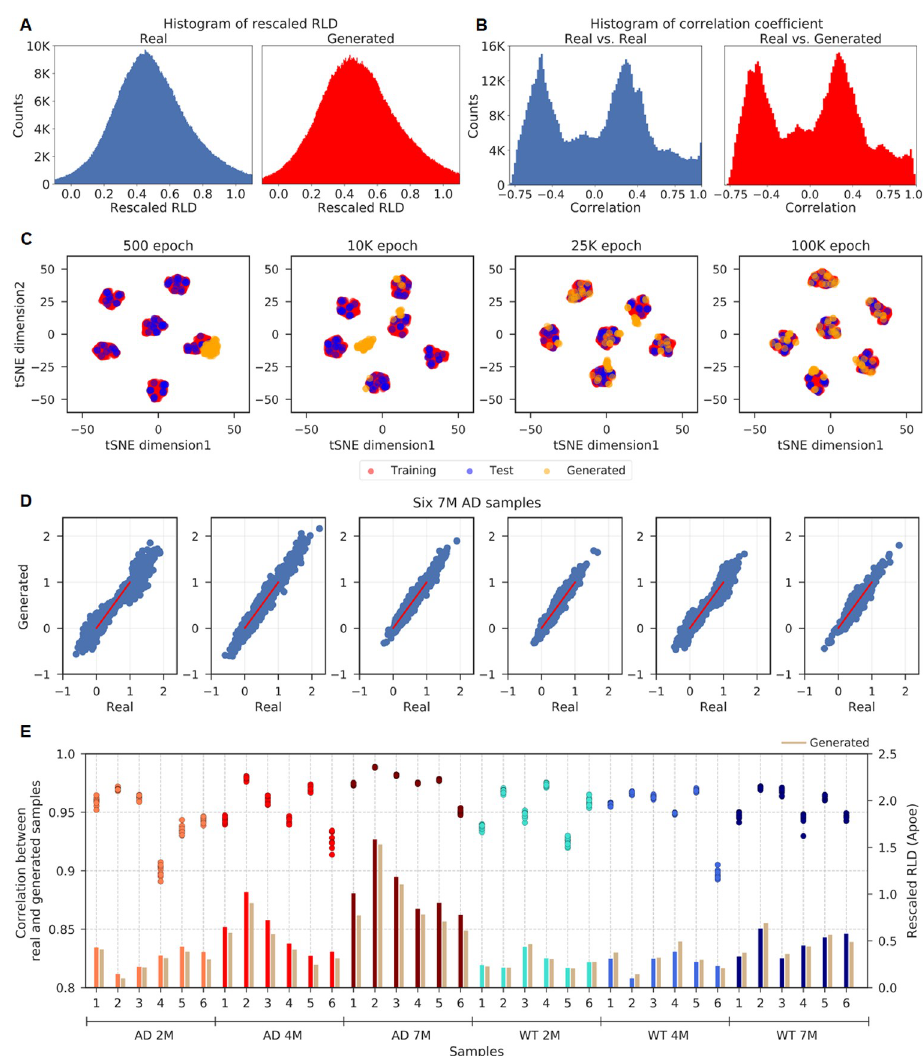
Fig 2. Generation of fake gene profiles. (A) The distribution plots of all rescaled RLD values for the 846 augmented real samples (blue) and the 846 generated samples (red). 95% of the real and 93% of the generated values lie within [0, 1]. (B) Correlation coefficient distributions for all pairs within the 846 real data (blue) and for pairs between the 846 real and 846 fake data (red) at the 100k epoch. The two broad peaks represent the correlation coefficients within the same group and between different groups. (C) tSNE plots at four epochs with different colored dots representing the 762 training (red) samples, 84 test (blue) samples and 84 generated samples (orange). Remarkably, we observed well- separated clusters per group in the tSNE plots due to the process of pairwise data augmentation performed within a group. (D) The scatterplots of the rescaled RLD values of the 1,208 genes for six 7M AD samples vs the corresponding resembled fakes. (E) The rescaled RLD values of the Apoe gene for 36 samples and their resembled fakes (generated; mauve color), which were generated at the 100k epoch. The scattered points of the correlation coefficients stand for different evaluations over ten repeated generations of 10,000 fake data. Low variations of correlation coefficients indicate that the fake data averaged in the latent space seem to be robust and have similar values under the given weight parameters of the generator